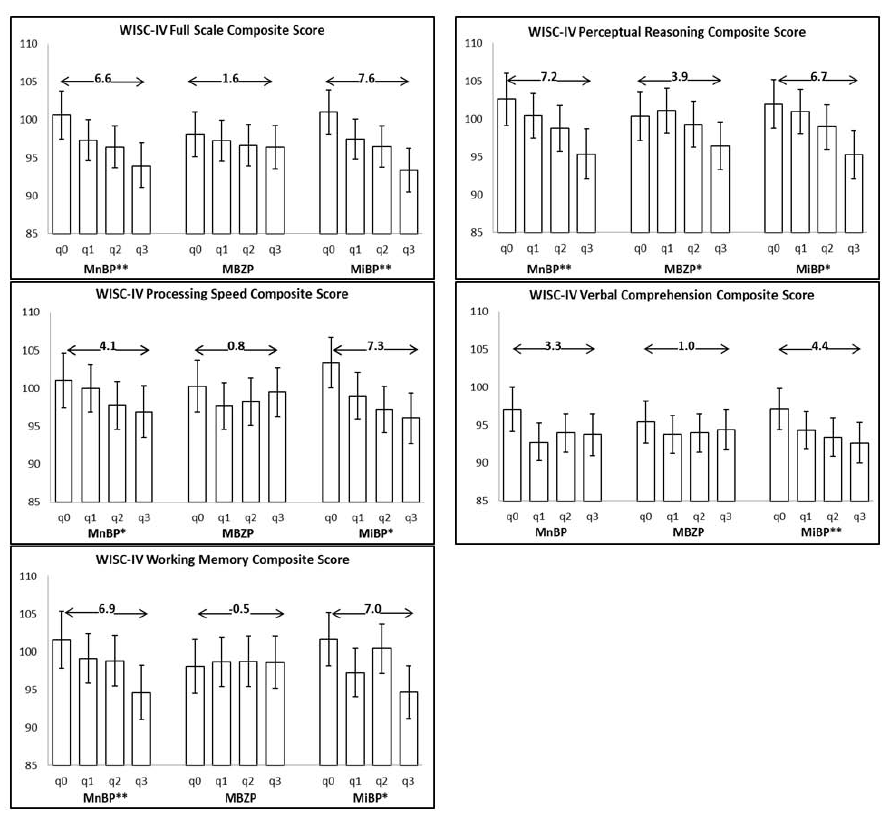
Figure 1. Adjusted mean WISC-IV total score and subtest scored by lowest to highest quartile of maternal prenatal phthalate metabolite concentration (where q0 5 lowest quartile, q4 5 highest quartile, q2 and q3 intermediate quartiles). Means adjusted for urine specific gravity, maternal IQ, ethnicity, alcohol use during pregnancy, education, marital status, quality of the home environment (HOME score) and sex of child. * p , 0.05, ** p #